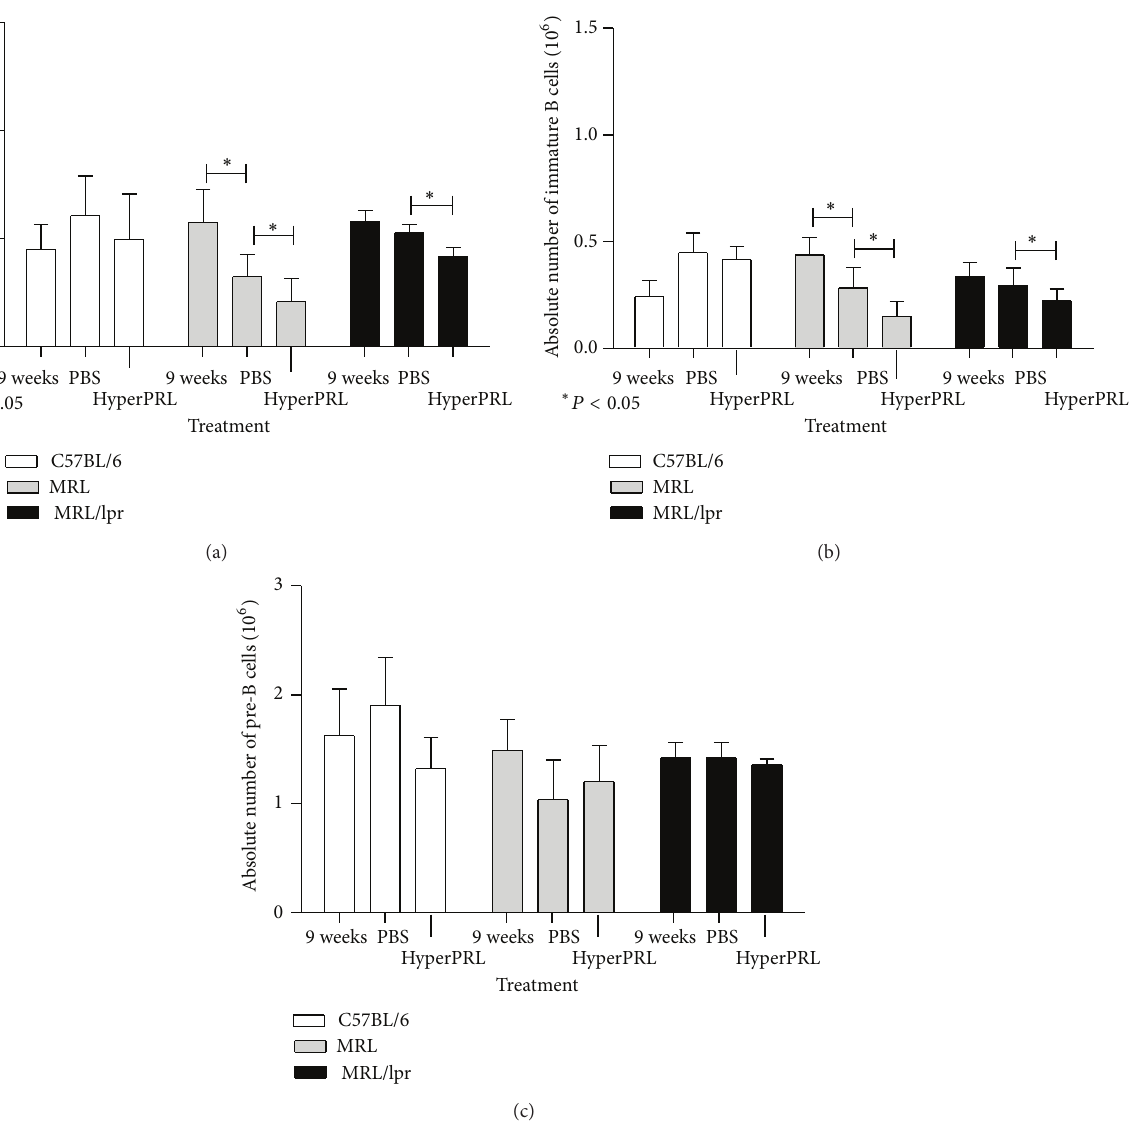
Figure 4: Absolute number of B cells from bone marrow after the induction of hyperprolactinaemia. Nine-week-old mice were treated with metoclopramide (200 𝜇 g/100 𝜇 L) to induce hyperprolactinaemia (HyperPRL) or PBS (100 𝜇 L) for 6 weeks, with eight mice per condition. At the end of the treatment, bone marrow cells were labelled with antibodies against B220, CD43, CD23, and IgM. (a) Graph of the absolute numbers of pro-B cells. (b) Graph of the absolute numbers of immature B cells. (c) Graph of the absolute numbers of pre-B cells. The asterisks denote statistical significance between populations with the 𝑃 value